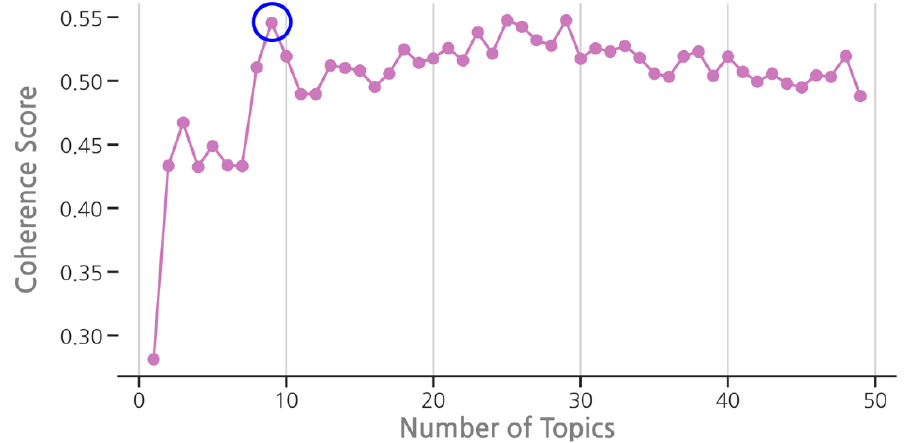
Figure 7. Coherence score ( C v ), taken by varying the number of topics from 1 to 49.